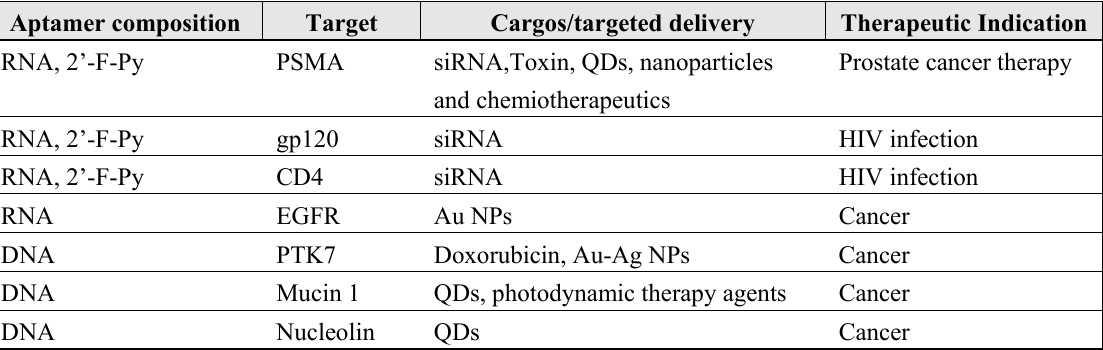
Table 2. Aptamers as delivery